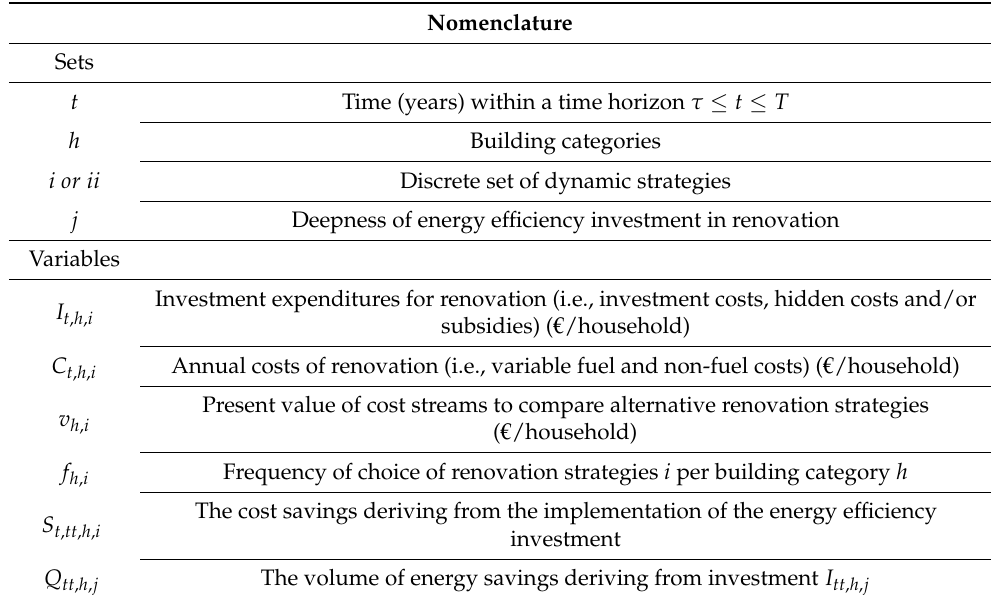
Table A3. Nomenclature of the PRIMES-BuiMo and scenario